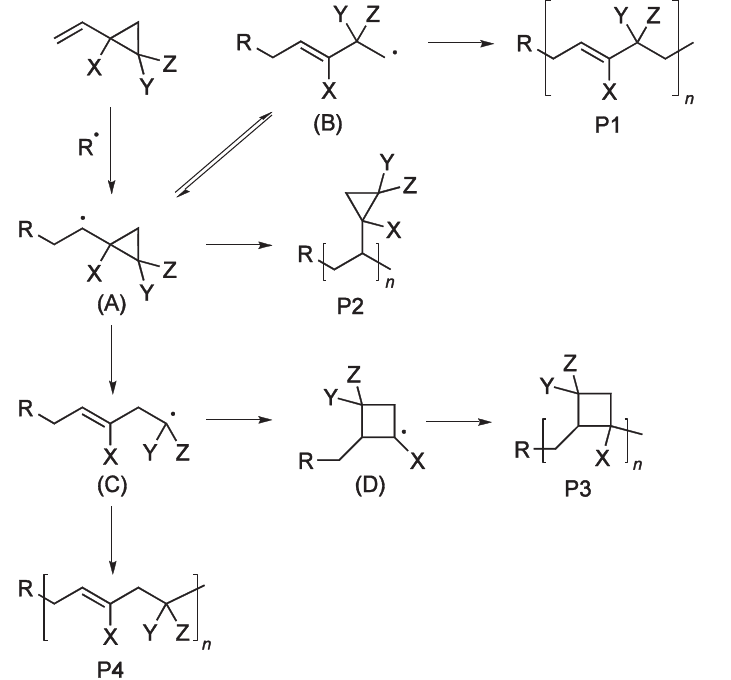
Figure 1. The radical ring opening polymerization (RROP) of a bicyclobutane [7].